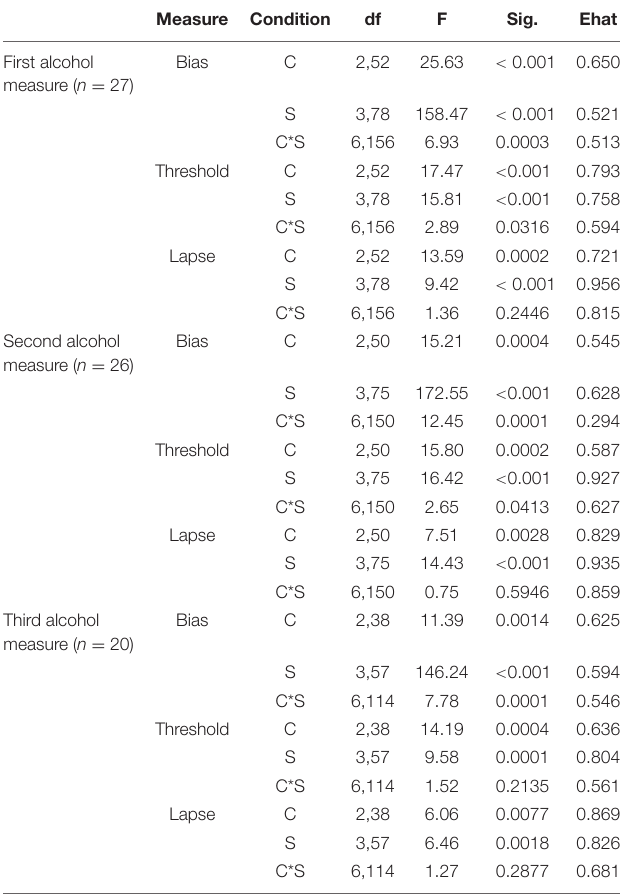
TABLE 1 | ANOVA table results for each alcohol measure. Measure Condition df F Sig.